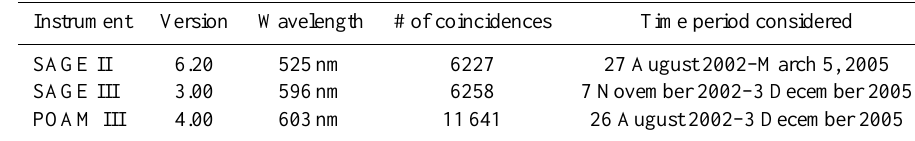
Table 1. GOMOS aerosol extinction retrievals: comparison data set; coincidence window: (500km, 1/2 day) Fig. 3. Comparison of GOMOS aerosol extinction pro(cid:2)les with other satellite measurements: SAGE II at 525 nm (left panel), SAGE III at 596 nm (middle panel) and POAM III at 603 nm (right panel). Shown are the statistics for the relative differences, calculated as